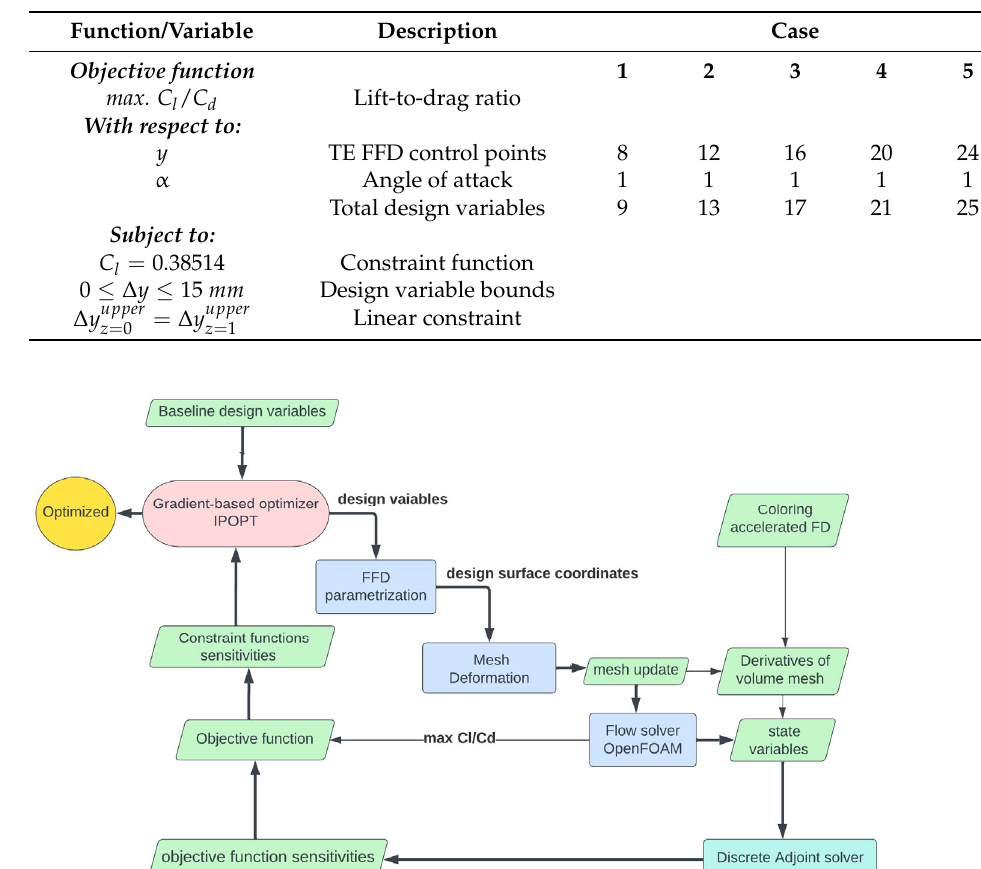
Figure 4. Overall optimization process of the UAS-S45 morphing wing trailing edge within the DAFoam optimization framework.